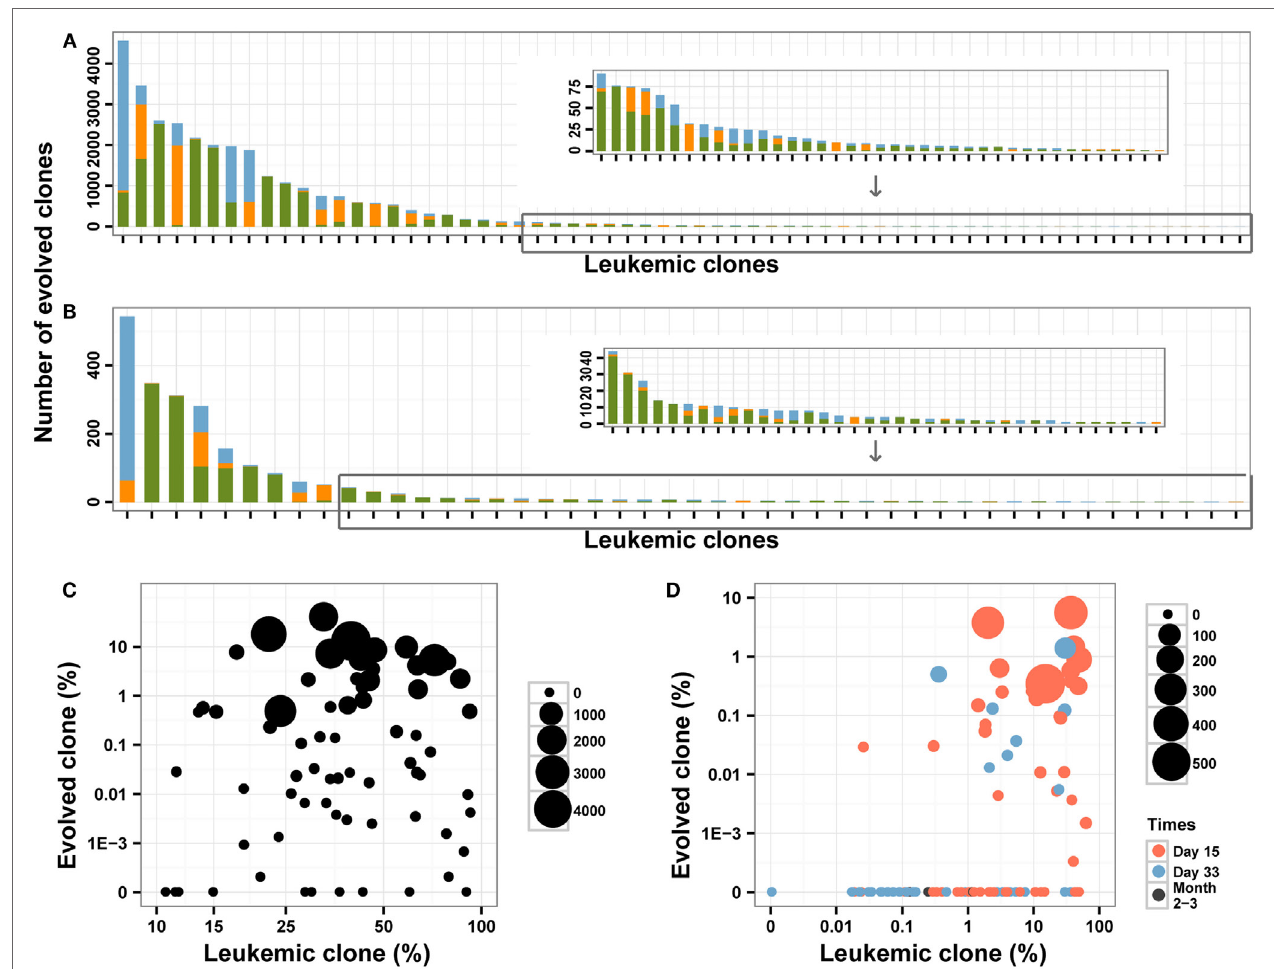
FigUre 4 | The evolved clones in pre-treatment and post-treatment bone marrow (BM) samples . (a,B) The number of evolved clones in pre-treatment (a) and follow-up (B) BM samples. Different colors indicate different relative position (green for upstream, orange for downstream, and blue for uncertain) for the evolved clonotypes compared to the leukemic clones. (c,D) The correlation between the leukemic clonal frequencies and the evolved clones in pre-treatment (c) and post-treatment (D) samples. The size of the point indicates the unique number of evolved clones from each leukemic clone, and colors in (D) indicated the time of BM obtained after the beginning of